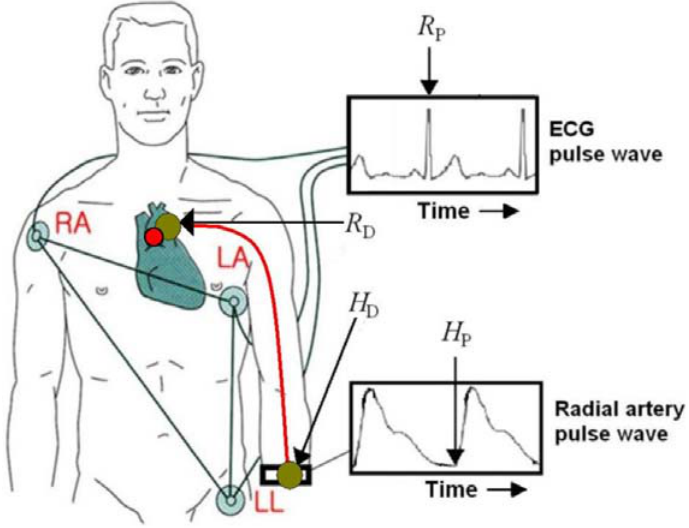
Figure 6. Configuration of electrocardiograph (ECG) and radial artery pulsimeter for the , R , H , and H are maximum peaks of the ECG pulse measurement of PWV. Here R P D P D waves, distance of aortic valve position, starting point of radial artery pulse wave, and distance of radial wrist position, respectively. Here, the red filled circle and the red solid line are the exact position of aortic valve and the rough distance from aortic valve to wrist,